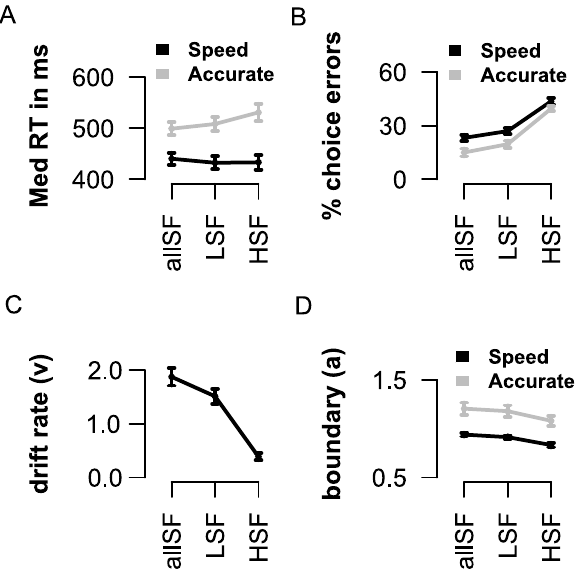
Figure 7. Effects of spatial frequency on decision-making. A) The difference between speeded- and accurate- reaction times (SAT) increased over the three frequency conditions. B) Overall, error rates increased over the three conditions while the SAT in % choice errors became smaller between fast and accurate trials. Computational modeling indicated that the speed of information accumulation is decreased over the three conditions (C). The amount of information required to produce a response is higher when instructed to respond accurately, but decreases across the frequency conditions for both speeded and accurate instruction trials (D).